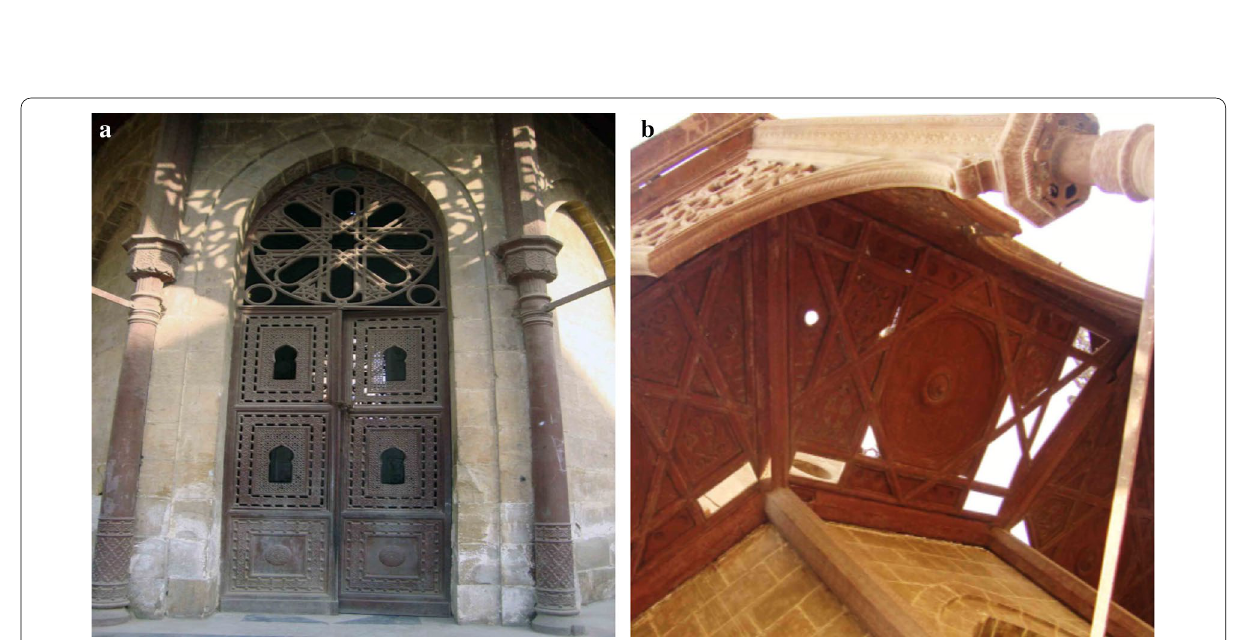
Fig. 2 a Main gate of the tomb and b missing parts in the